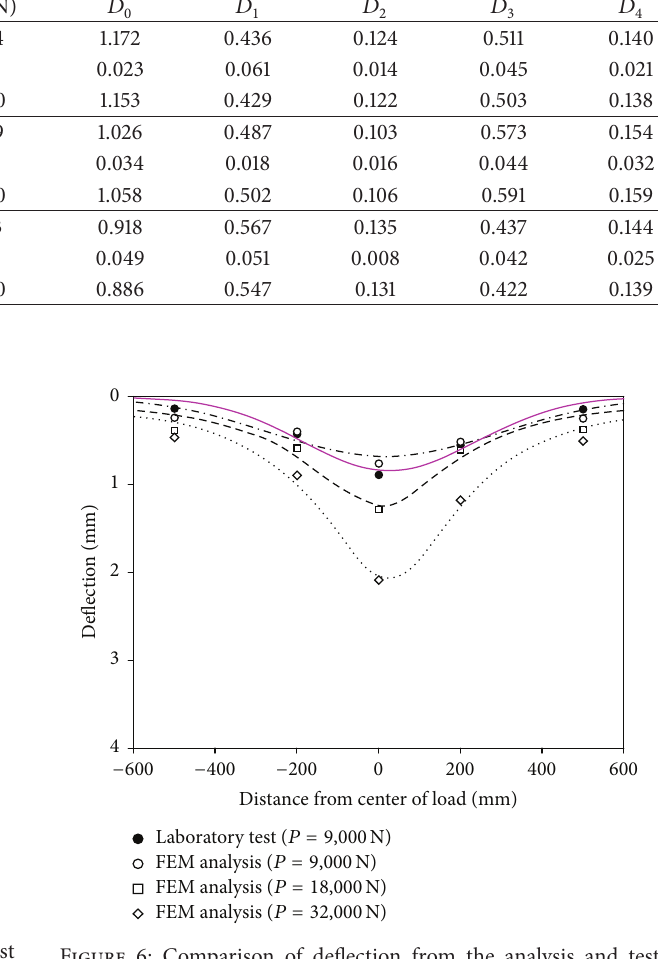
Figure 6: Comparison of deflection from the analysis and test